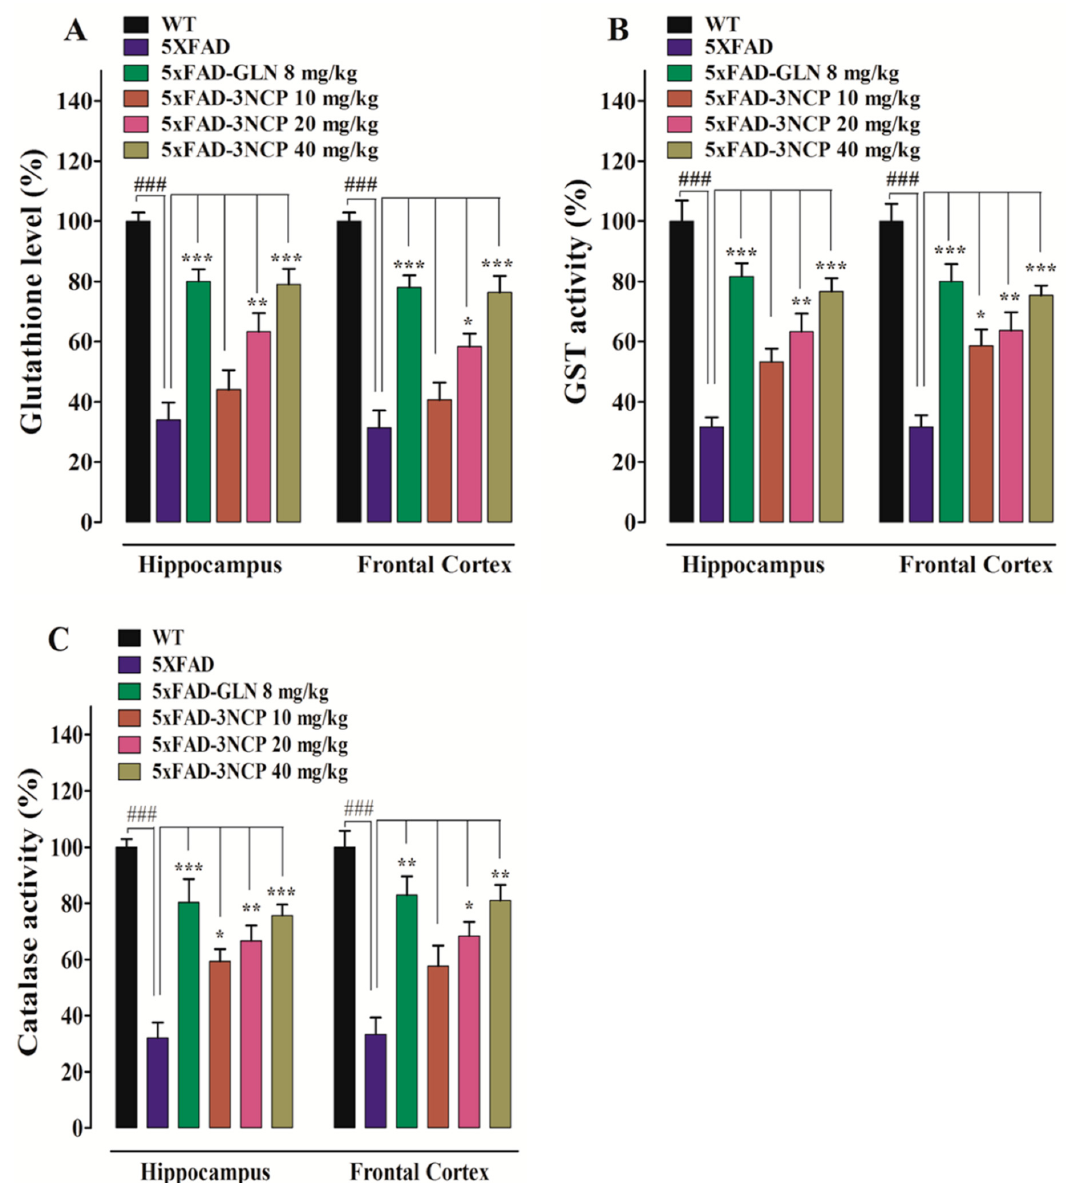
Figure 6. The effect of the 3NCP on %-level of GSH ( A ), %-activity of GST ( B ), and catalase ( C ), in the FC and HC. Bars displays mean level/activities (%) ± SEM.* p < 0.05, ** p < 0.01, *** p < 0.001 compared to 5xFAD group and ### p < 0.001 compared to non-transgenic WT-group, one-way ANOVA followed by Tukey’s post hoc test ( n =